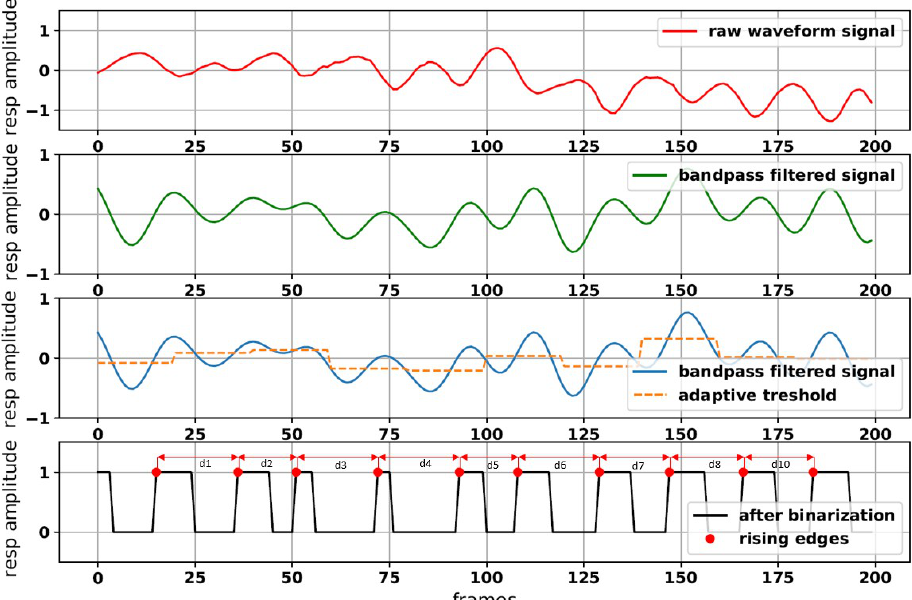
Figure 6. Operation method of the classical rate calculation (CalcRate). The BR is calculated by 1/(Mdi/20) · 60 where Mdi is the mean of d distances between the rising edges of actual